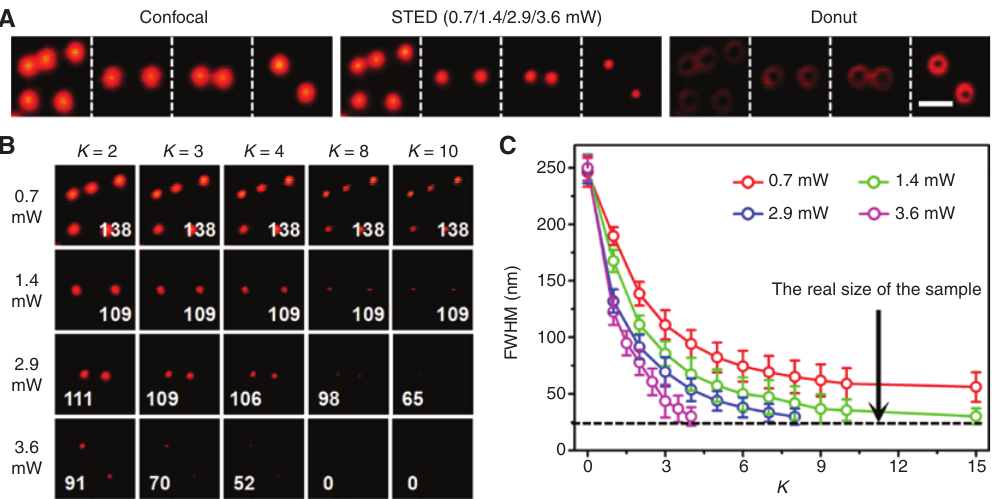
Figure 4: Digital enhancement for resolution improvement when imaging 23-nm fluorescent beads. (A) Confocal images at four imaging positions, and STED images at four depletion powers, as well as the corresponding donut images. FOV: 4.8 × 4.8 μ m 2 . (B) Digitally enhanced STED images at increased enhancement coefficient. Note: The number in each subimage denotes the peak intensity. (C) The dependence of DE-STED imaging resolution on the enhancement coefficient for four depletion